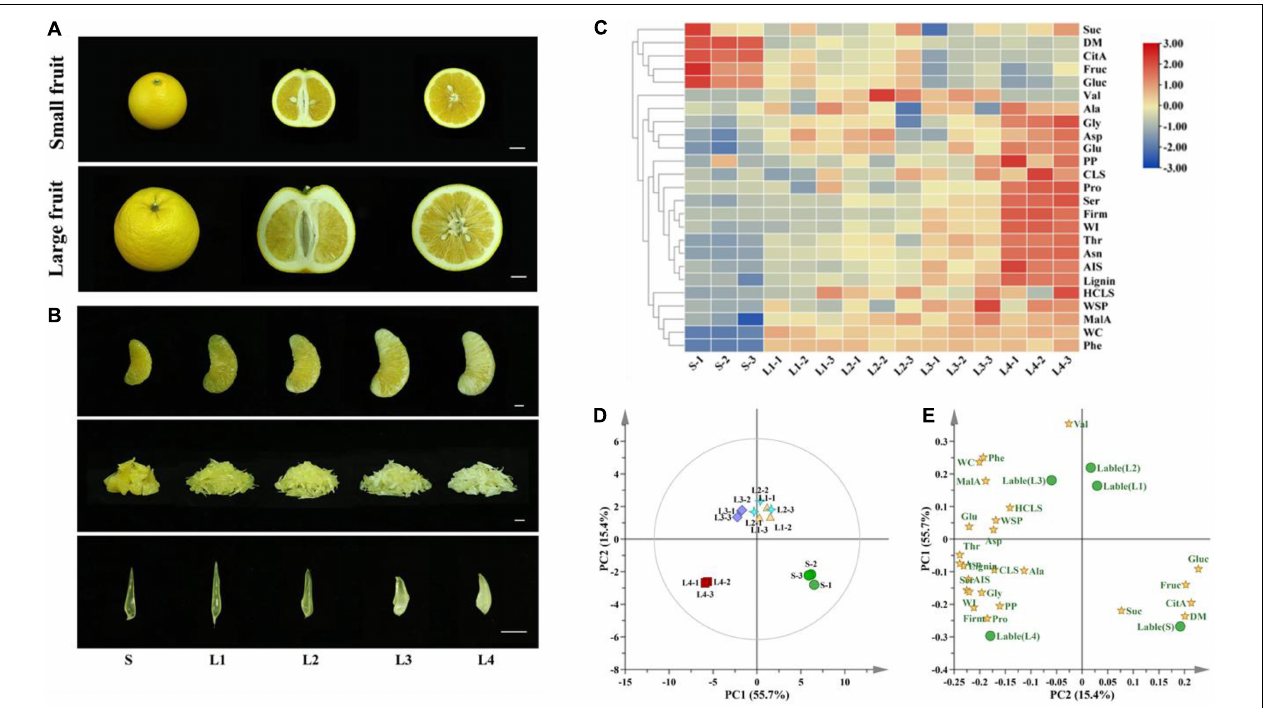
FIGURE 1 | Appearance and physiochemical characteristics of Huyou juice sacs in different granulation degrees. (A) Appearance of small-size and large-size fruit. Bar = 2 cm. (B) Appearance of juice sacs. Bar = 1 cm. (C) Heatmap presenting the variation of physiochemical indexes. (D) PCA analysis of samples based on the physiochemical indexes. (E) Scores plot of different physiochemical indexes. S, juice sacs from small-size fruit. L1–L4, juice sacs from large-size fruit, which were classified according to the granulation degree. WC, water content; MalA, malic acid; Phe, phenylalanine; HCLS, hemicellulose; WSP, water-soluble pectin; Glu, glutamic acid; Asp, aspartic acid; Thr, threonine; Asn, asparagine; CLS, cellulose; Ala, alanine; Ser, serine; AIS, alcohol insoluble solids; Gly, glycine; PP, protopectin; WI, whiteness index; Pro, proline; Firm, firmness; Suc, sucrose; Fruc, fructose; Gluc, glucose; CitA, citric acid; DM, dry